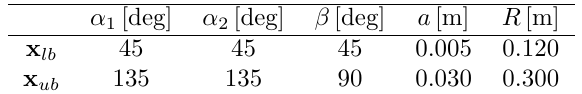
Table 1: The lower and upper bounds of the design variables x